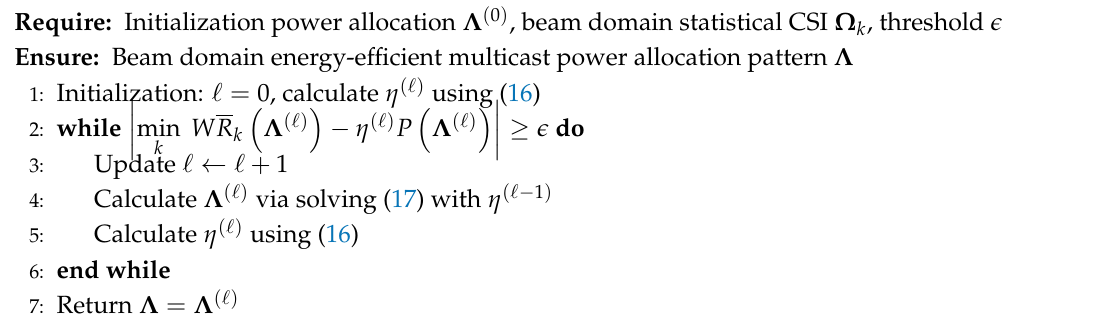
Algorithm 1 Beam Domain Energy-Efficient Multicast Power Allocation